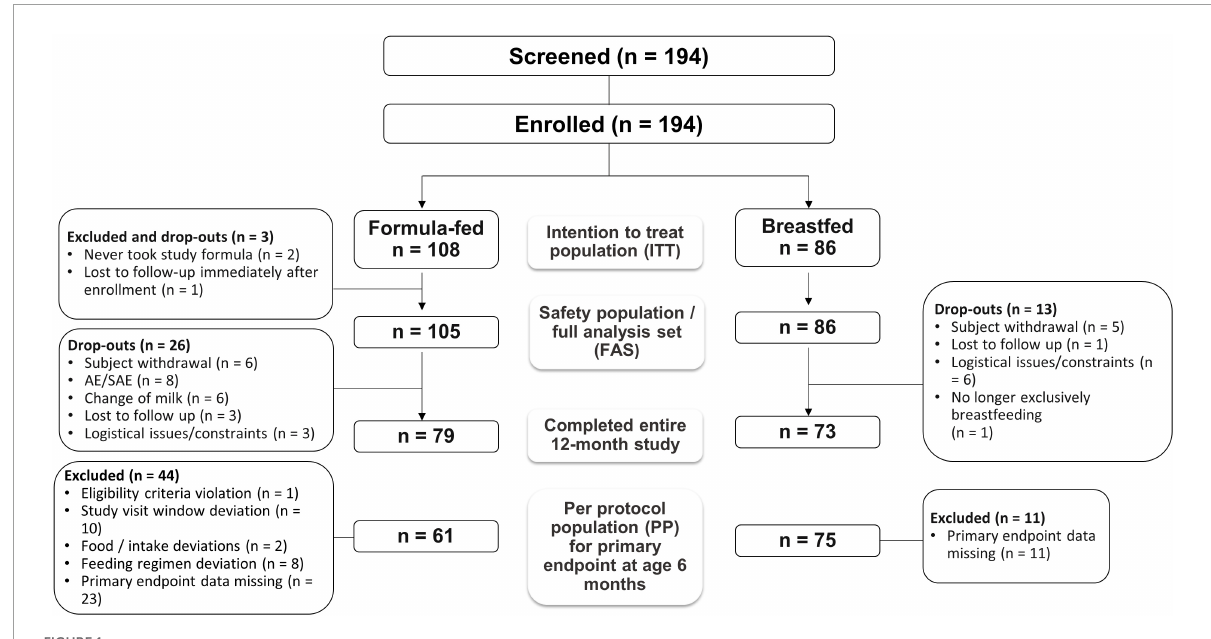
FIGURE1 Flow of study